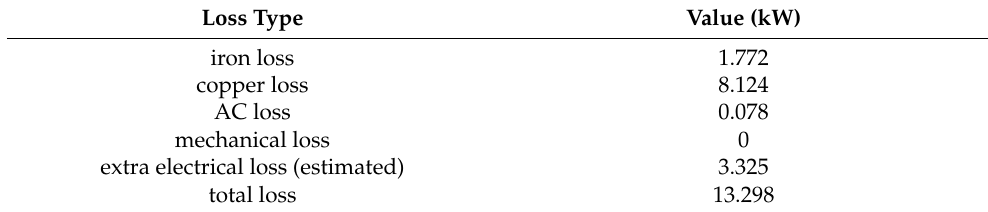
Table 4. Loss components of the generator.